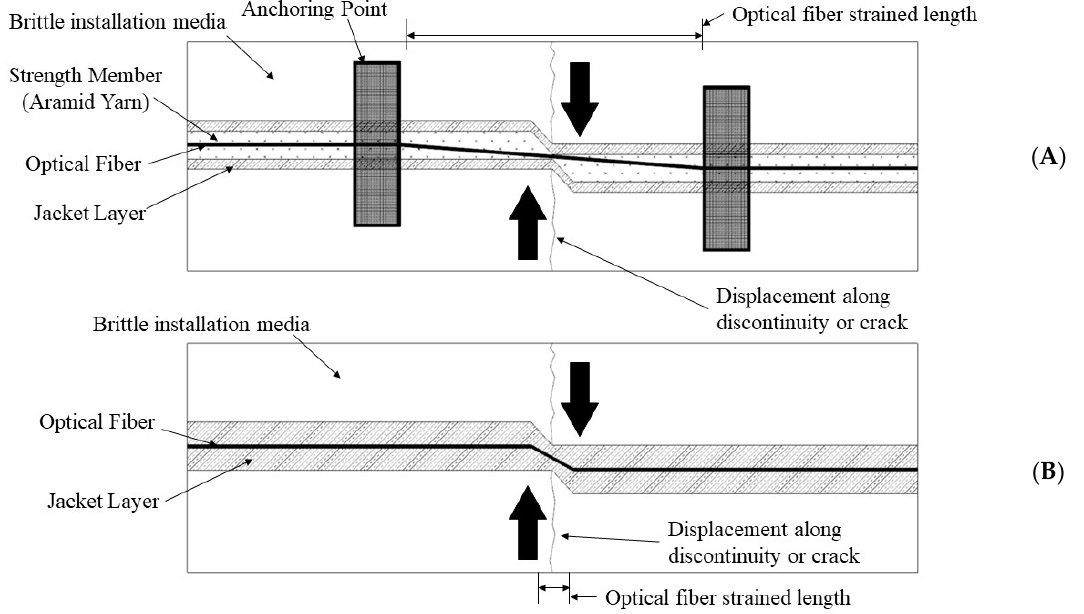
Figure 2. Schematic of the hybrid fiber optic cable for strain sensing in brittle installation media. ( A ) The hybrid fiber optic cable. Note that the optical fiber is insulated from highly localized strains and a known strained length is produced between anchoring points. ( B ) A tight jacketed optical fiber which is fixed to the installation media using the overall bonding technique. Note that a highly localized and thus undetectable strain is produced when displacement along the crack occurs.